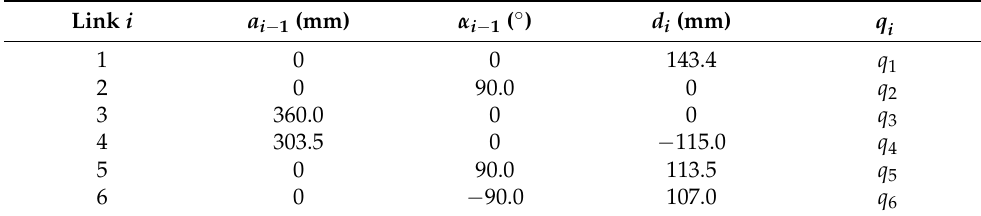
Table 2. D-H Parameters of 6-DOF JAKA